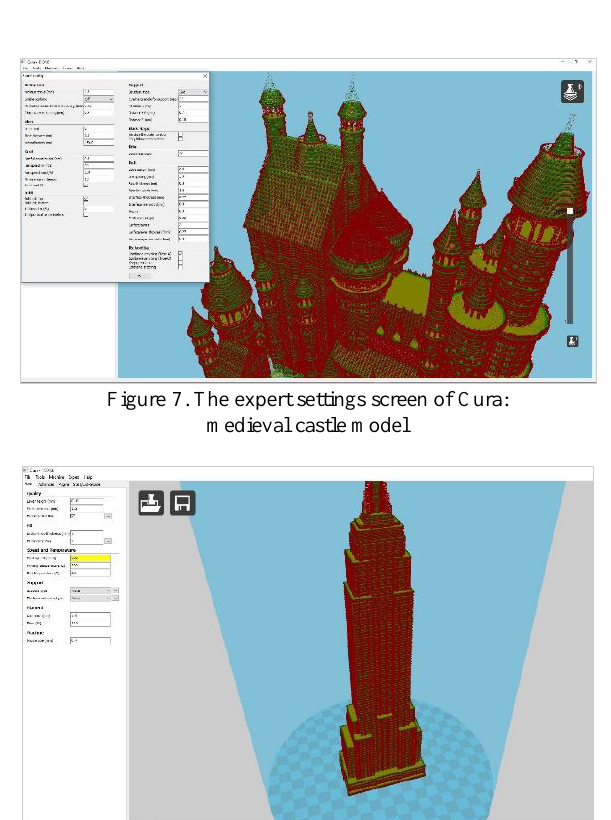
Figure 8. The main screen of Cura: Empire State Building model, layers view mode